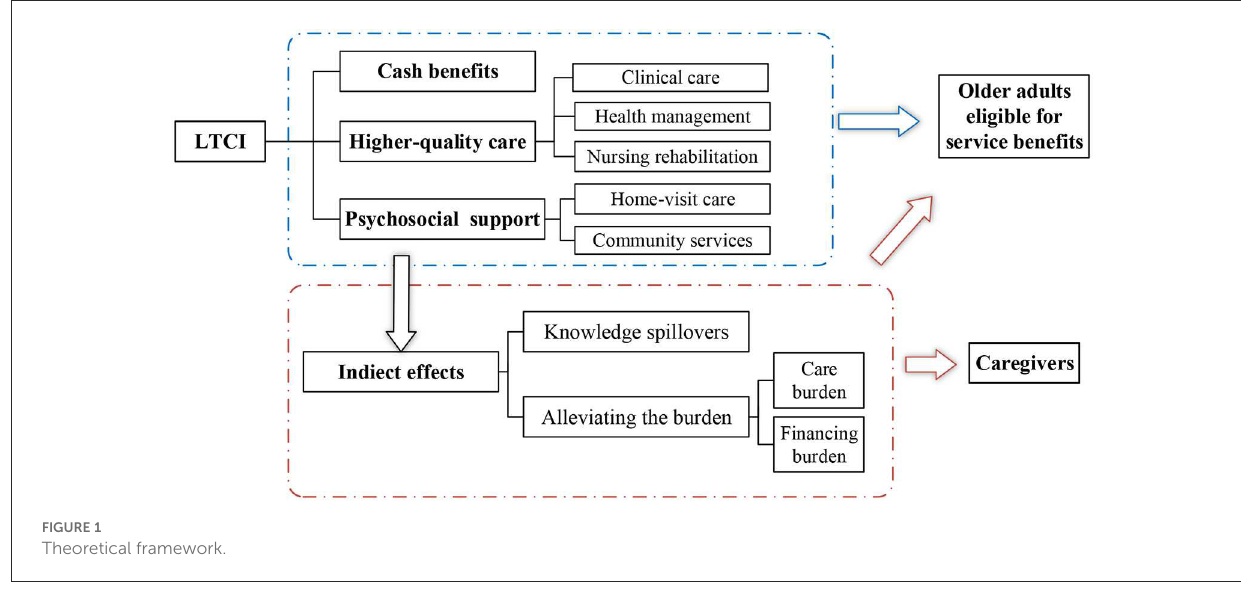
TABLE 3 Descriptive